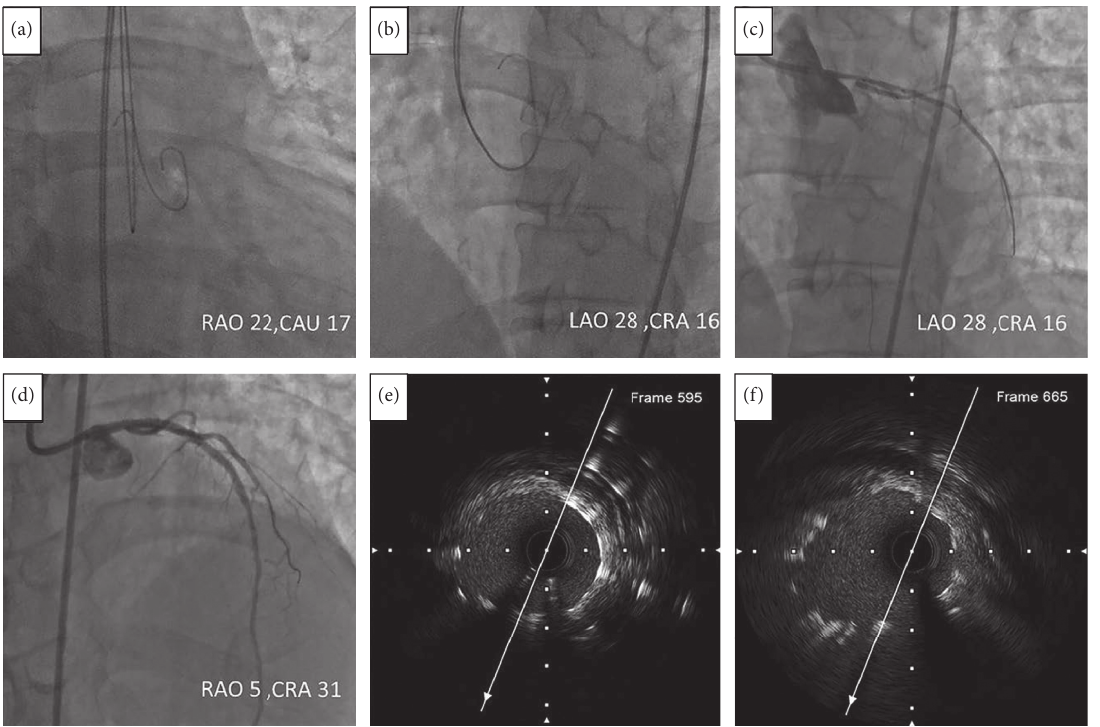
Figure 8: (a) Two 0.035-inch wires were advanced to the NCC and RCC using the RAO and CAU view; (b) the lowest points in the curve at the distal part of these two wires were superimposed at LAO 28/CRA 16; (c) the stent was located at the angulation; (d) the image of LMCA after stent deployed at RAO 5/CRA 31; (e) in the poststenting pullback with the speed of one millimeter equal to 60 frames, the LMCA ostium was at frame 595; (f) the stent ostium was at frame 665. So the stent protruded to the aorta for 1.17mm ((665–595)/60). CAU � caudal; CRA � cranial; LAO � left anterior oblique; RAO � right anterior